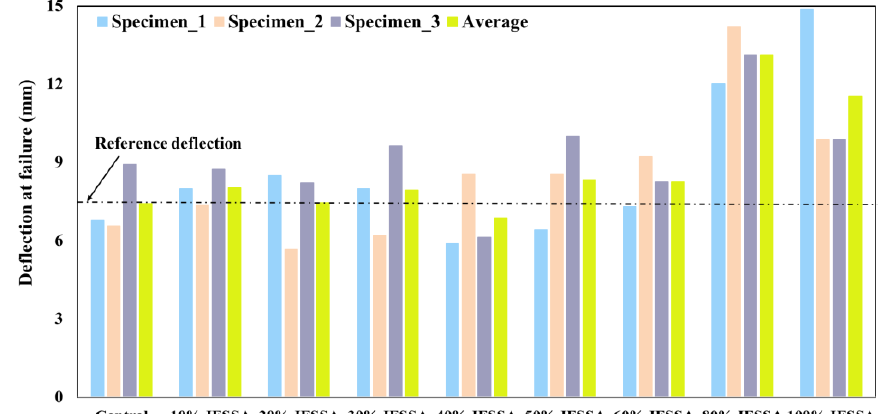
Figure 8. Mid-span deflection at the failure of the RC beams.